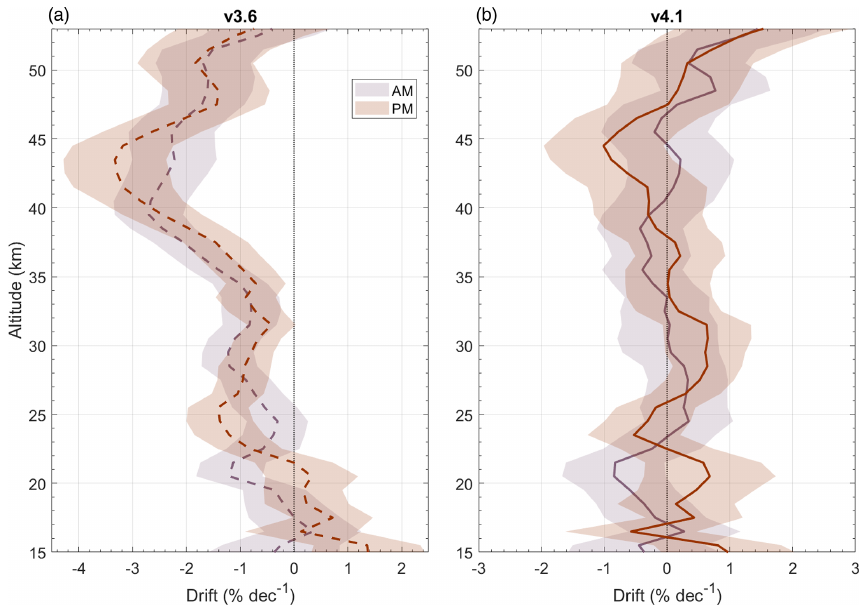
Figure 10. Weighted-average ACE-FTS drift profiles for AM and PM comparisons in relative terms. (a) ACE-FTS v3.6, (b) v4.1. Shaded regions (semitransparent) represent 99% confidence bounds.